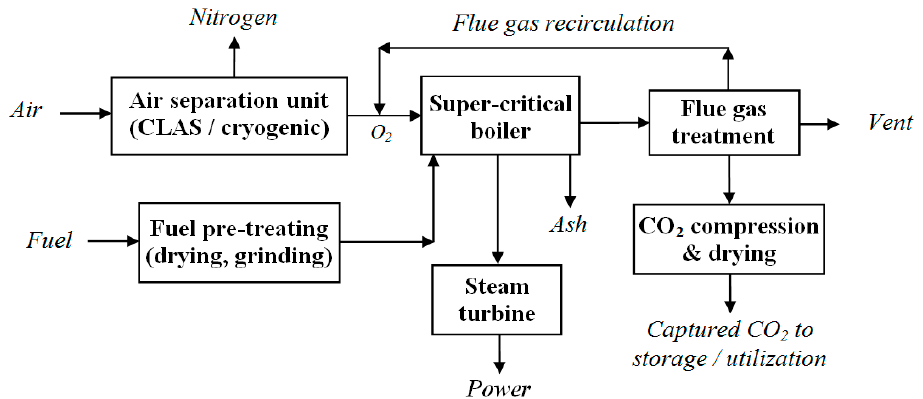
Figure 2. Design of oxy-fuel combustion power plant with CO 2 capture.